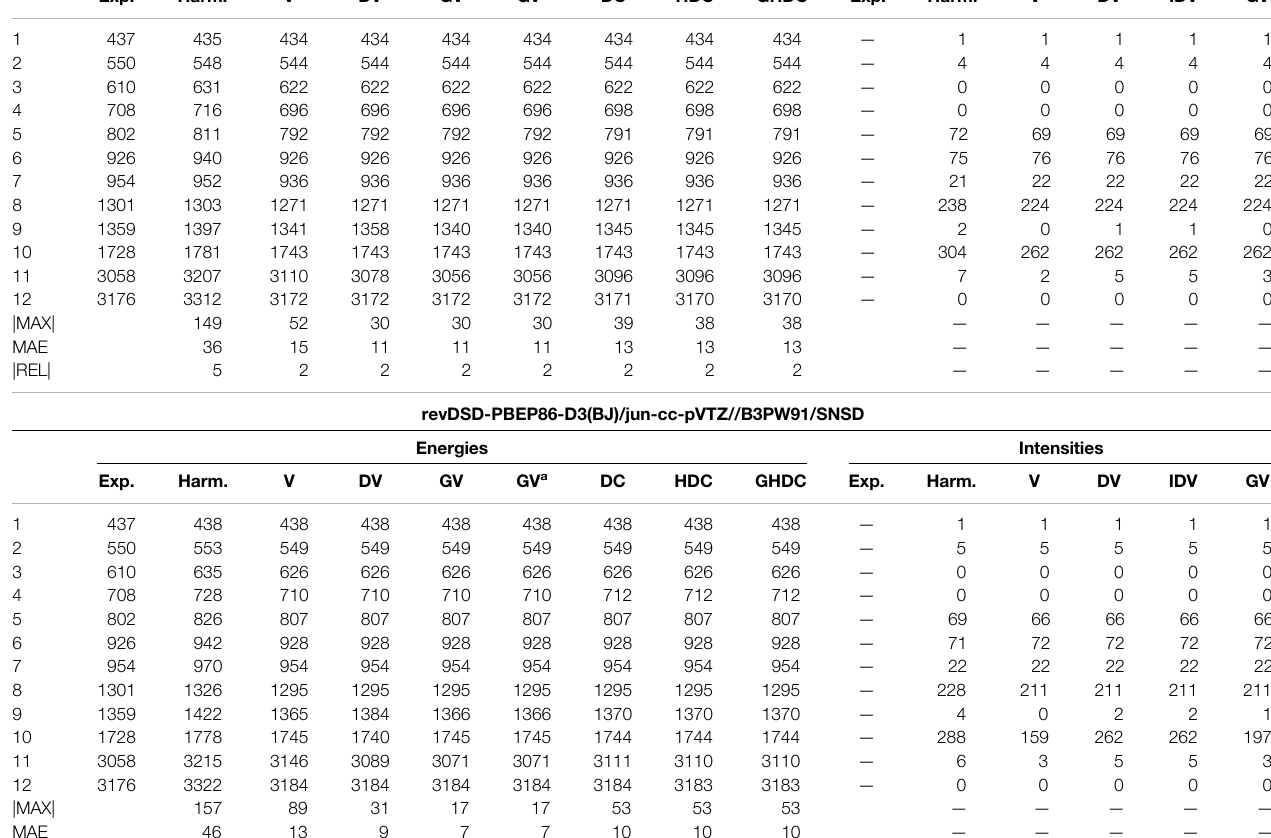
TABLE 4 | Harmonic and anharmonic vibrational energies (in cm − 1 ) and intensities (km/mol) of 1,1-di fl uoroethylene computed at the B3PW91/SNSD and hybrid revDSD- PBEP86-D3(BJ)/jun-cc-pVTZ//B3PW91/SNSD levels of theory and withdifferent VPT2 schemes. The maximum (|MAX|) and mean (MAE) absolute errors, aswell asthe maximum relative error weighted by the reference value (|REL|, given in %) are reported with respect to experimental data from (Tasinato et al., 2006). B3PW91/SNSD